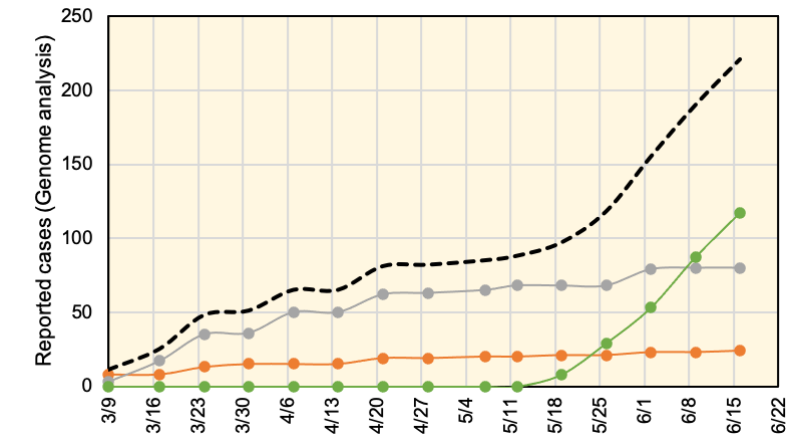
Figure 10. Cumulative number of COVID-19 viral variant reported cases in Japan using genome analysis. The top side of the chart demonstrates all variants, in which the Alpha variant represents approximately 95% of the reported cases. After May 26, the Alpha variant was considered dom- inant and excluded from the analysis report. The bottom side of the chart shows viral variants excluding